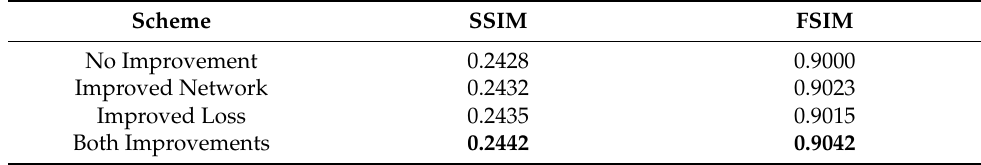
Table 3. The model generated result indicators under different improvement measures. The number in bold indicates the optimal value under the corresponding